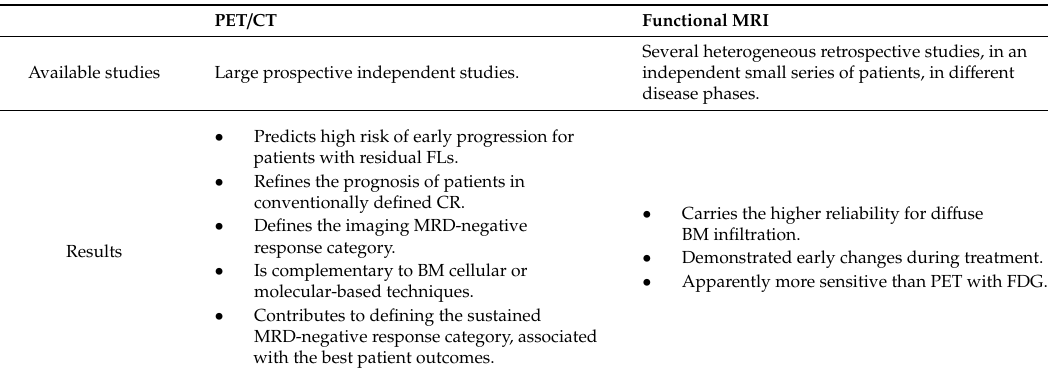
Table 2. PET / CT and MRI in the evaluation of response to